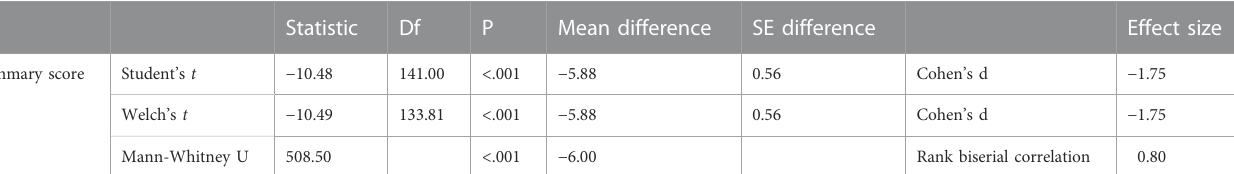
TABLE 8 Difference in patient satisfaction between groups.